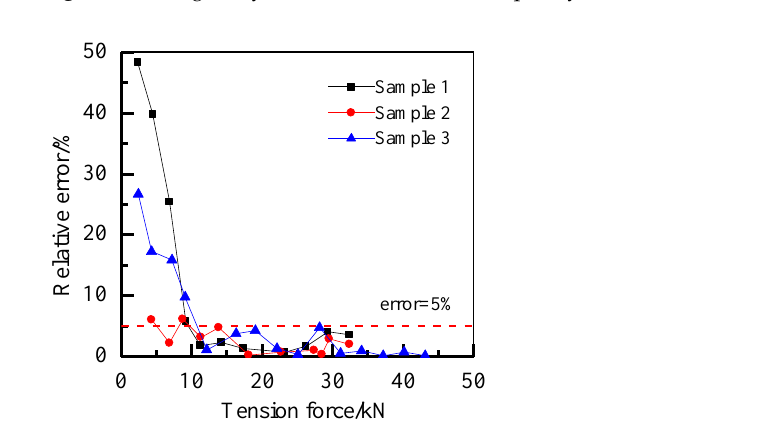
Figure 5. Fitting analysis between vibration frequency and tension force.